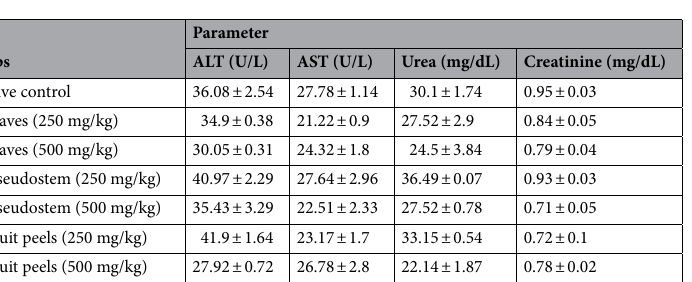
Table 3. Effect of oral administration of MA leaves, pseudostem and fruit peels extracts on liver and kidney function tests of rats in subchronic toxicity study. Results are expressed as means of levels of ALT, AST, urea and creatinine in rat sera ± SE. n = 8; Data were analysed using one way analysis of variance (ANOVA) followed by Tukey Kramer’s multiple comparison test. No significant difference detected among groups.